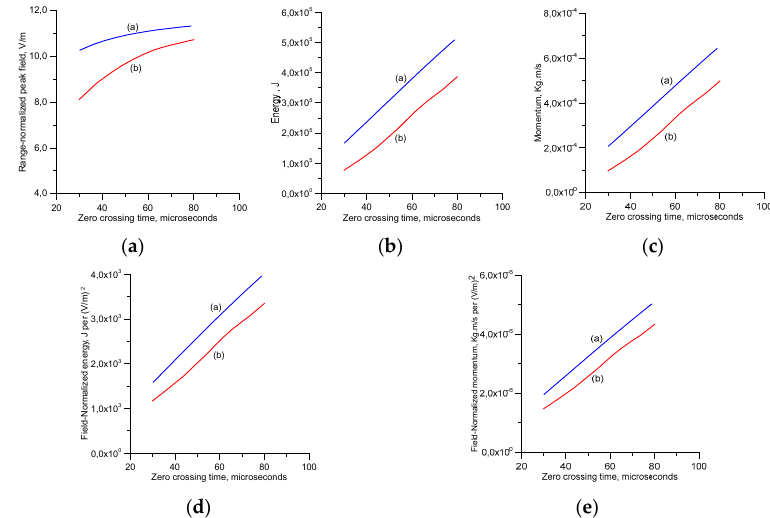
Figure 6. Results pertinent to first return strokes simulated by MTLL and MTLE models with a peak return stroke current of 30 kA and a return stroke speed equal to 2 × 10 8 m / s. ( a ) The range-normalized (to 100 km) peak amplitude of the radiation field as a function of the zero-crossing time; ( b ) The energy radiated as a function of the zero-crossing time; ( c ) The momentum radiated as a function of the zero-crossing time; ( d ) The field-normalized energy (as defined by dividing the energy by the square of the radiation field peak at 100 km); ( e ) The field-normalized momentum (as defined by dividing the momentum by the square of the radiation field peak at 100 km). Curve (a) corresponds to the MTLL model, and curve (b) corresponds to the MTLE model.